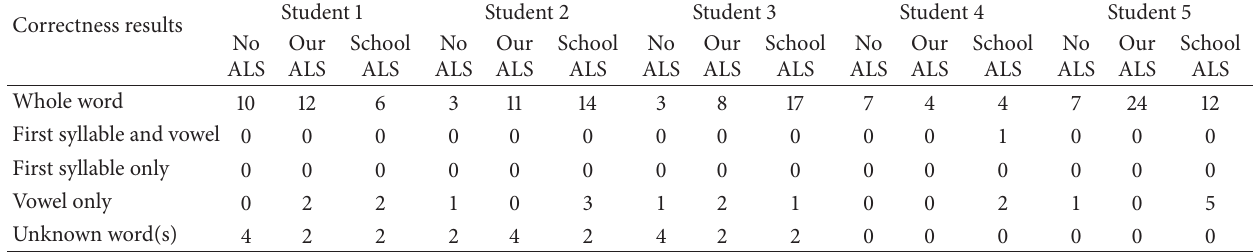
Table 1: Field test results by students.